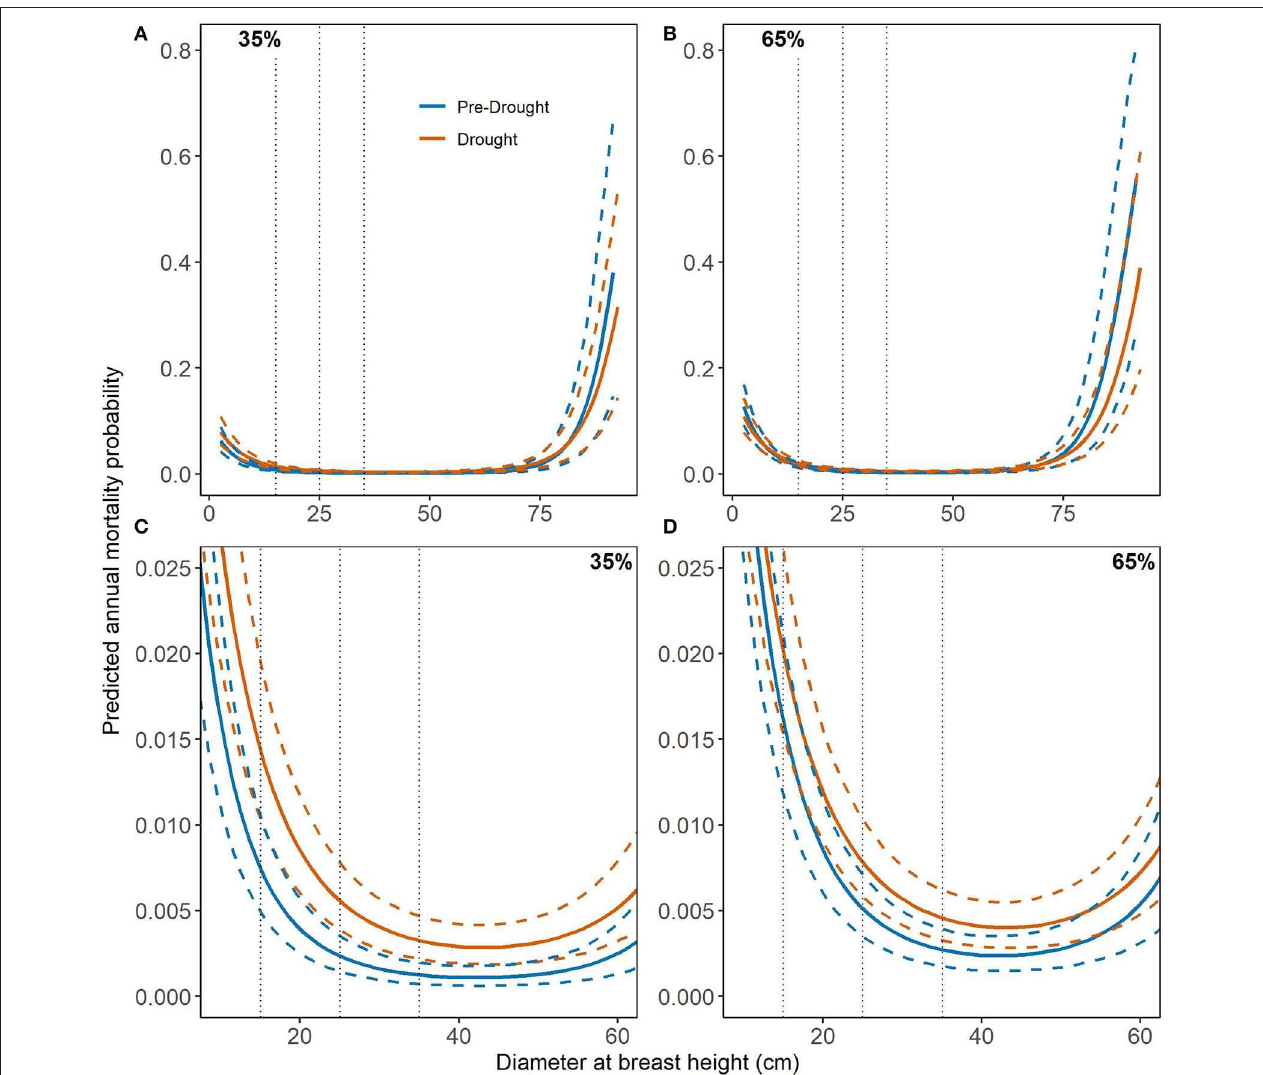
FIGURE 4 | Mortality curves (solid lines) for naturally-regenerated loblolly pine (NL) and diameter at breast height (DBH) with 95% credible intervals (dashed lines). Relative density (RD) is held constant at the lower (35%) and upper (65%) limits of fully-stocked conditions while species dominance (SPD) is held constant at its median values ( ∼ 60%, see Table 1 ). Pre-drought period trees were measured and re-measured from 2003 to 2010 while drought period trees were initially measured prior to 2011 and re-measured 2012–2016. Dotted lines highlight merchantable size classes of 15, 25, and 35cm DBH. (A,B) show mortality curves across the full range of DBH values in the dataset while (C,D) display notable differences which occur at small and mid-range DBH